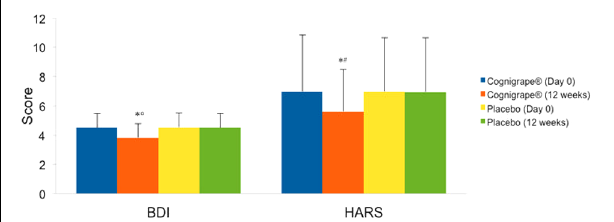
FIGURE 2 | Effects of Cognigrape or placebo supplementation for 12 weeks on Beck Depression Inventory (BDI) and Hamilton Anxiety Rating Scale (IIARS) scores in healthy older adults. ∗ p < 0.0001 vs. Cognigrape (Day 0); ◦ p < 0.0001 vs. Placebo (12 weeks): # p < 0.05 vs. Placebo (12